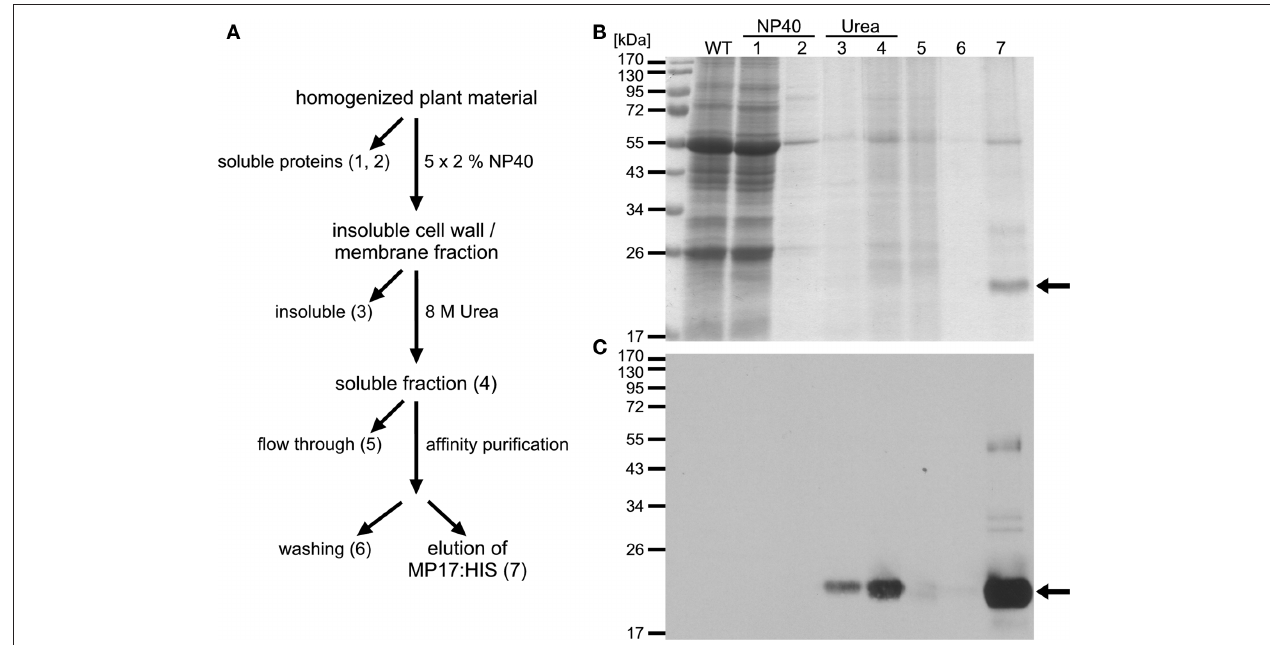
was used for affinity purification on Nickel-NTA resin; fraction 5 represents the flow through and fraction 6 the last wash; bound proteins were eluted with EDTA (7); (B) Aliquots of the indicated purification steps (1–7) were separated by SDS-PAGE and stained with colloidal coomassie; (C) MP17:HIS (arrows) was